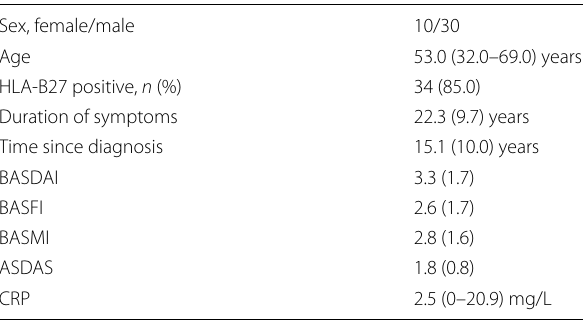
Table 1 Patient characteristics